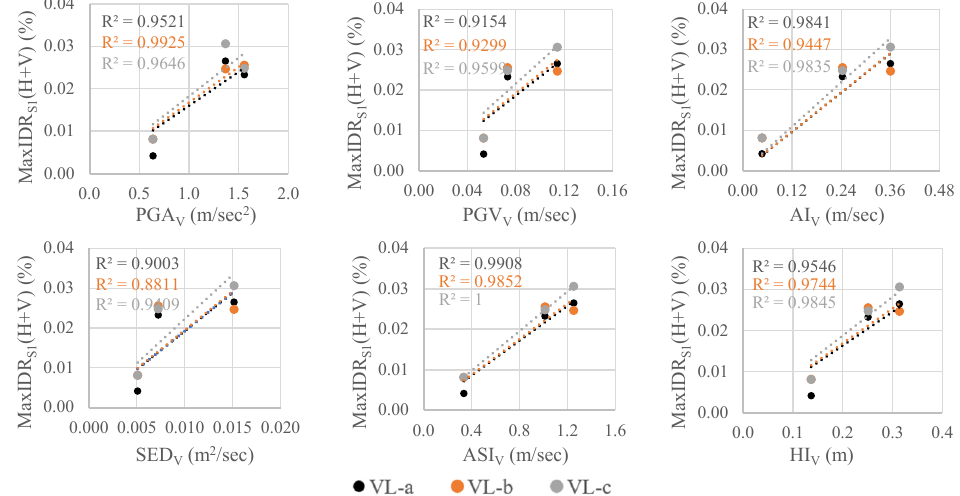
Figure 19. Correlations between the GMPs of the V components (GMP V ) and the maximum IDR obtained on the first story of the case–study structure from the simultaneous application of the H and V components, maxIDR S1 (H + V). In each image, with the only exception of PGA V plot, from left to right, earthquakes #3, #1, and #2; in the PGA V plot ( top left ), from left to right, earthquakes #3, #2, and #1.